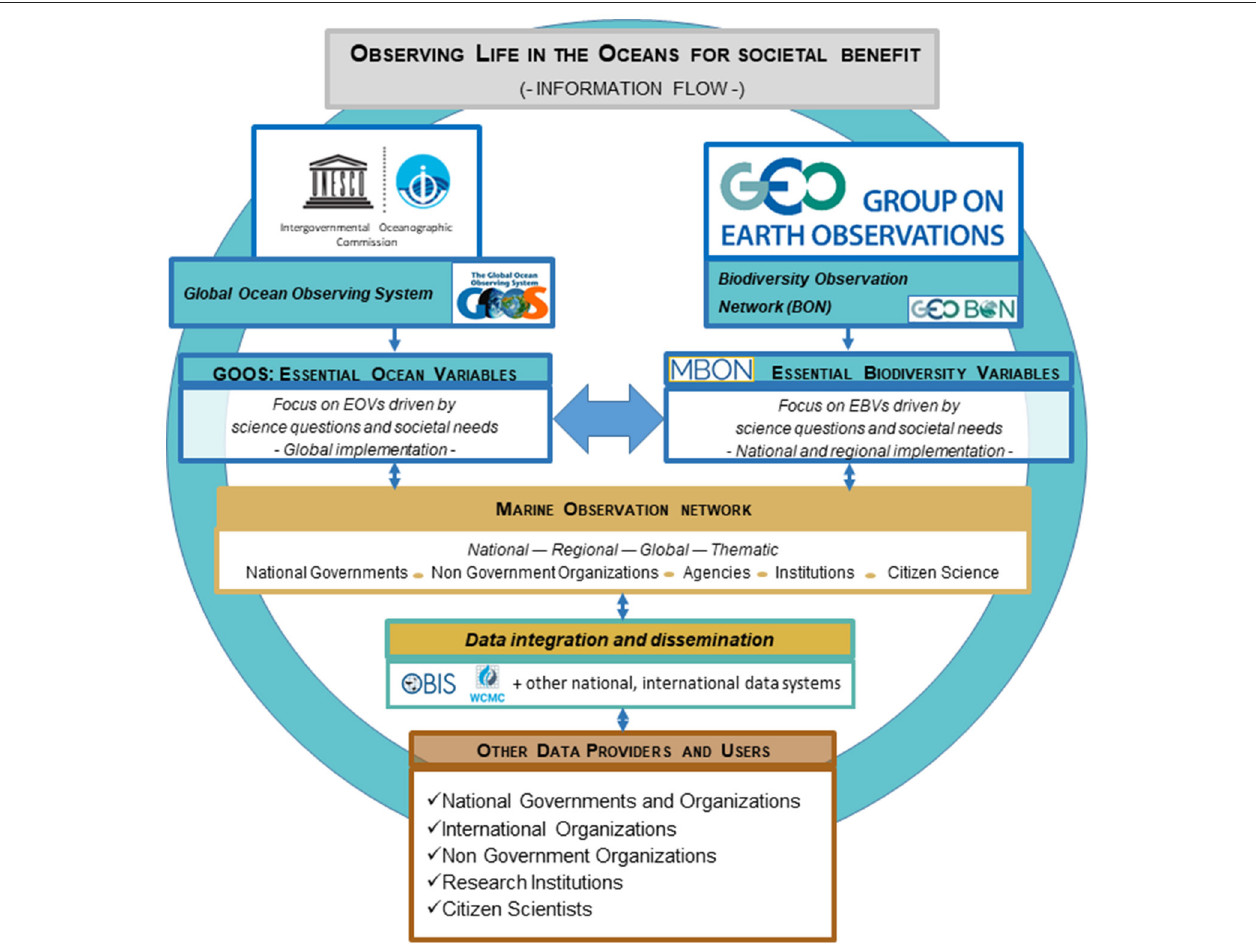
FIGURE 2 | Schematic of the linkages between the GEO BON Marine Biodiversity Observation Network (MBON), the Global Ocean Observing System (GOOS), and the Ocean Biogeographic Information System (OBIS) proposed for biodiversity assessments. The strategies for observing are defined by national government and organizations, non-governmental organizations, and research groups, in an iterative loop that links with the elements that integrate the GOOS, MBON, and OBIS networks. The outer (blue) circle highlights feedbacks, and indicates that there are direct linkages between the users and the top levels in the partnership, including the IOC, GEO BON and